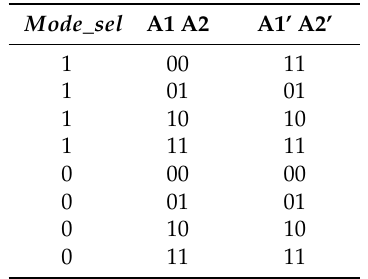
Figure 7. The data input and scan chain structure of key register. ( a ) the original data input and scan chain structure of key register. ( b ) the data input and scan chain structure of key register for the proposed technique. Table 1. The relation between {A1’, A2’ } and { Mode _ sel , A1,